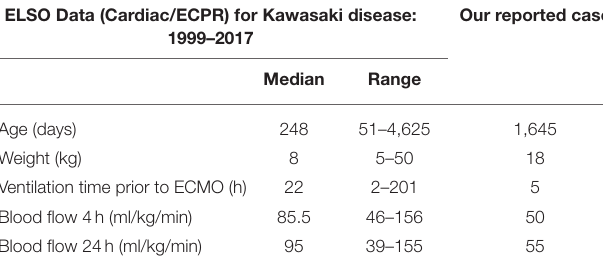
TABLE 2 | Clinical features in ELSO data comparing our case. ELSO Data (Cardiac/ECPR) for Kawasaki disease: